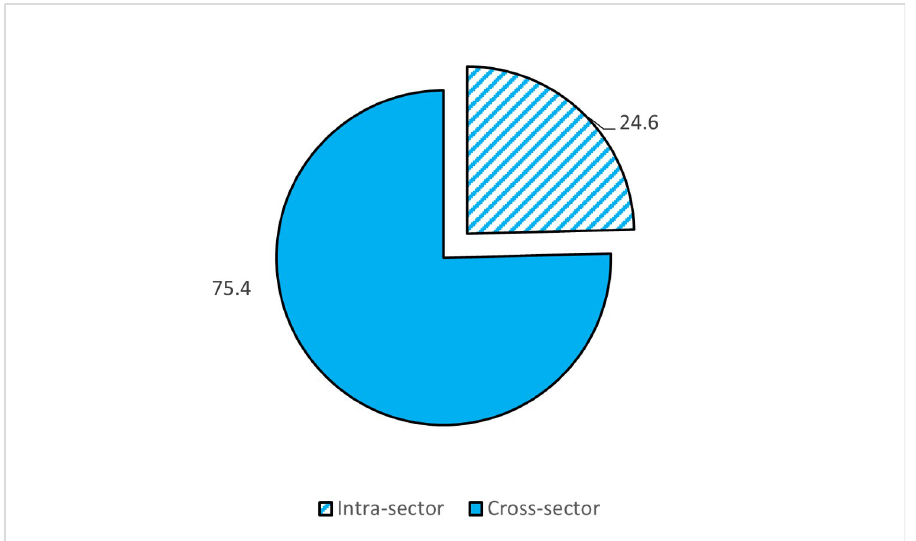
Fig 3. The institutional form of